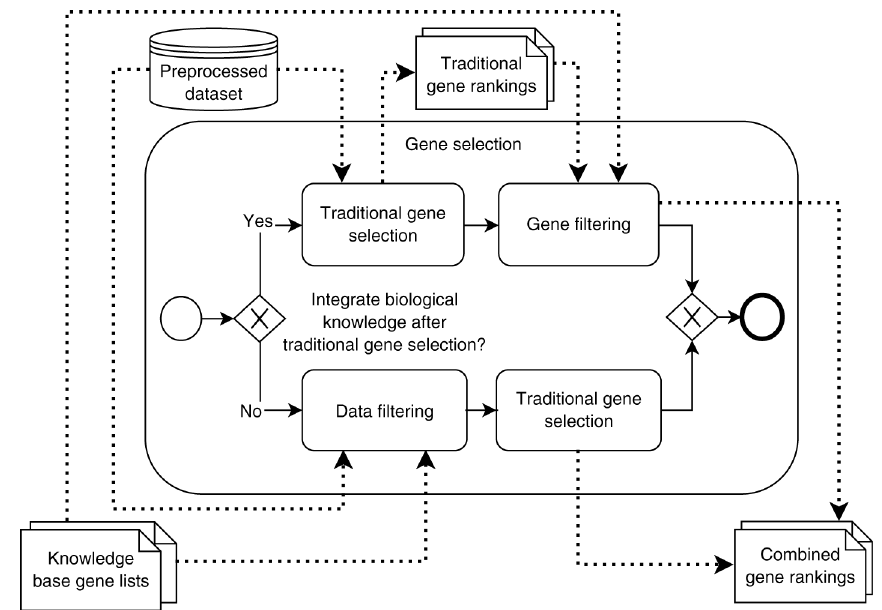
Figure 2: The actual gene selection step splits up into two alternatives data filtering and gene filtering, depending on when external knowledge is combined with traditional gene selection.